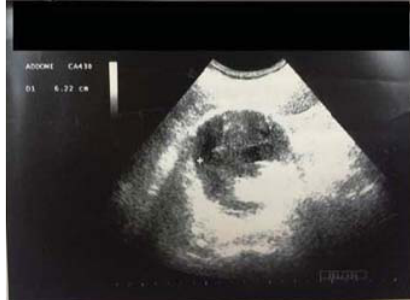
Figure 2: Ultrasound aspects of the renal hematoma.